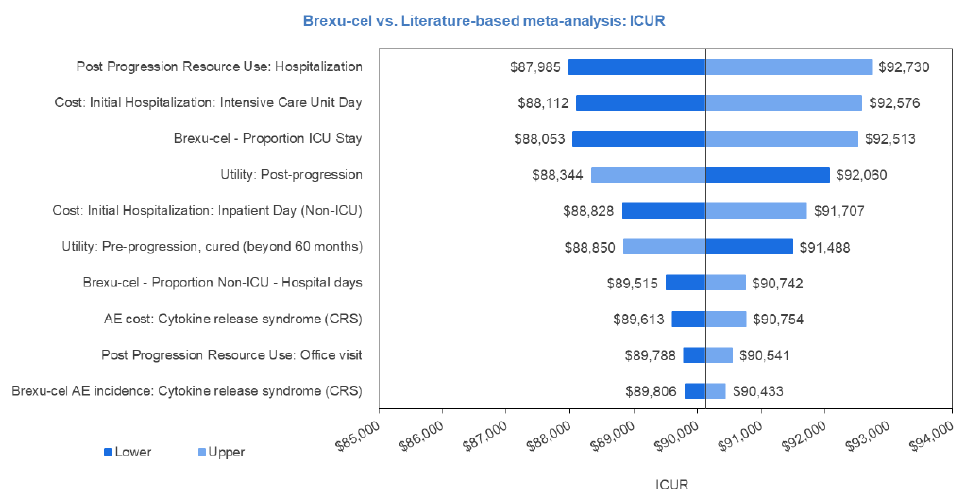
Figure 3. Univariate sensitivity analysis tornado plot. Abbreviations: AE, adverse event; ICU, intensive care unit. care